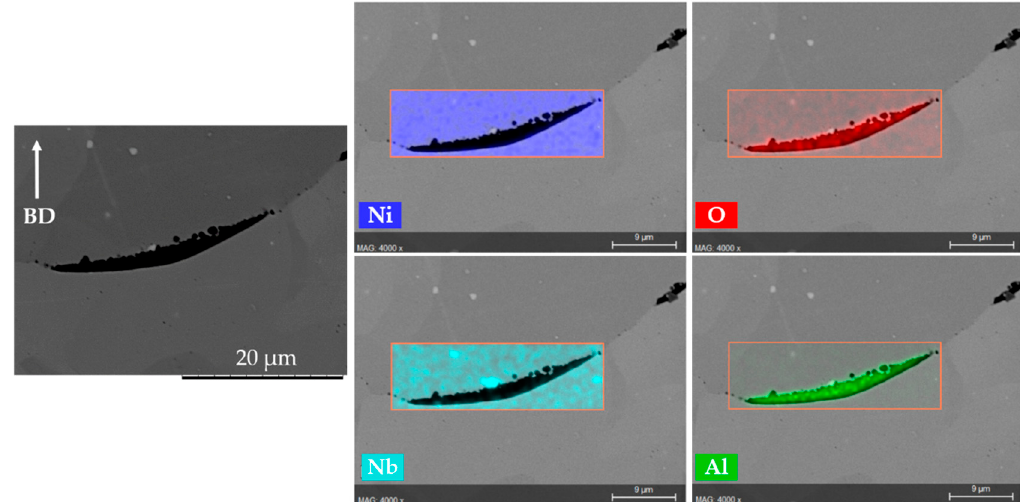
Figure 4. Representative EDS analysis showing inclusions typically associated with many remnant defects in sample #4 (LS = 225 µm) after HIP1. The arrow indicates the build